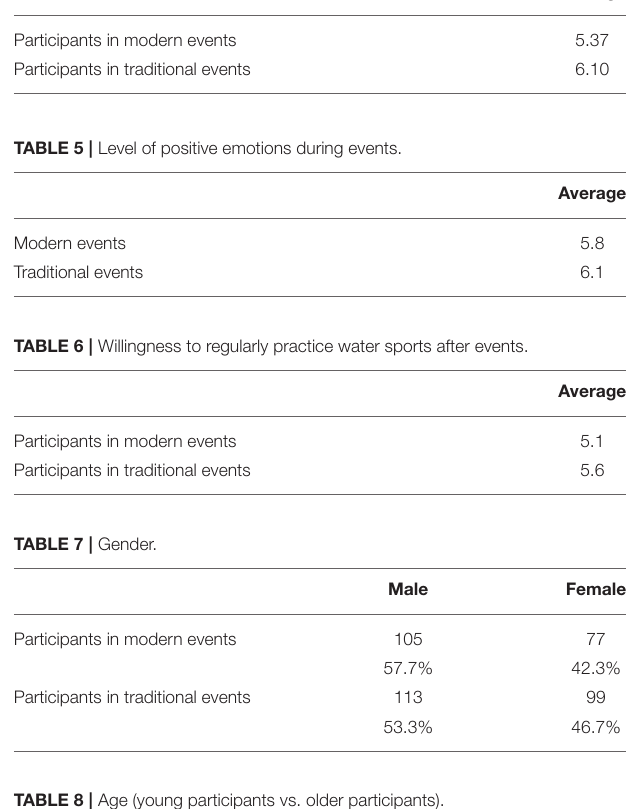
TABLE 8 | Age (young participants vs. older participants).